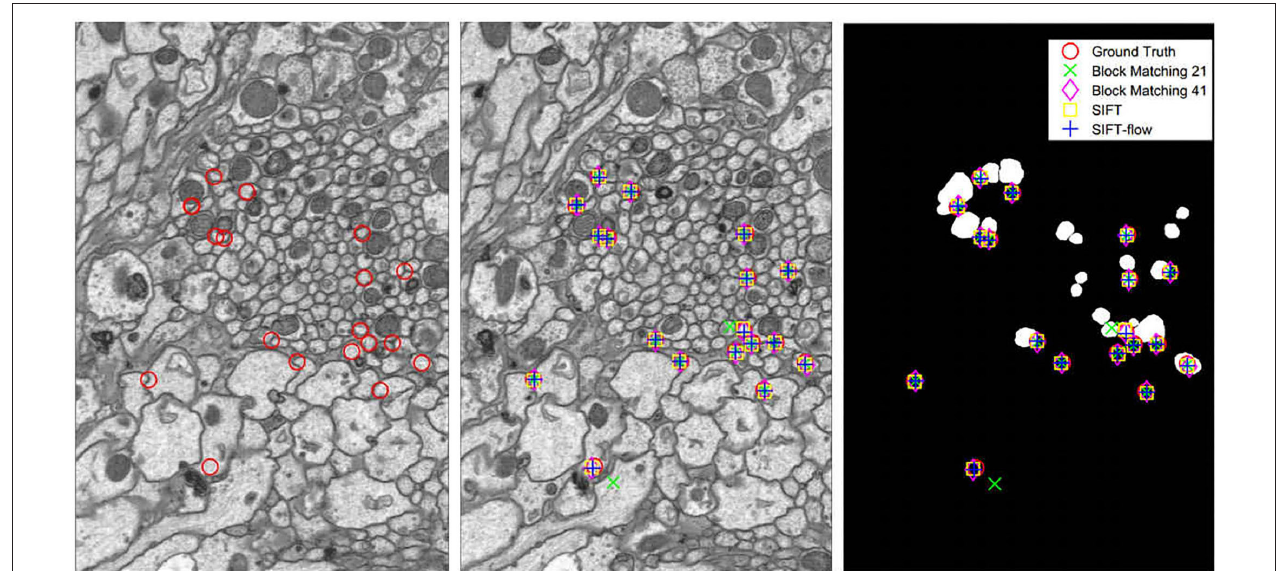
FIGURE 5 | Left: the points in the reference section. Middle: the correspondences extracted in the adjacent section. Right: the correspondences extracted in the selected region map.